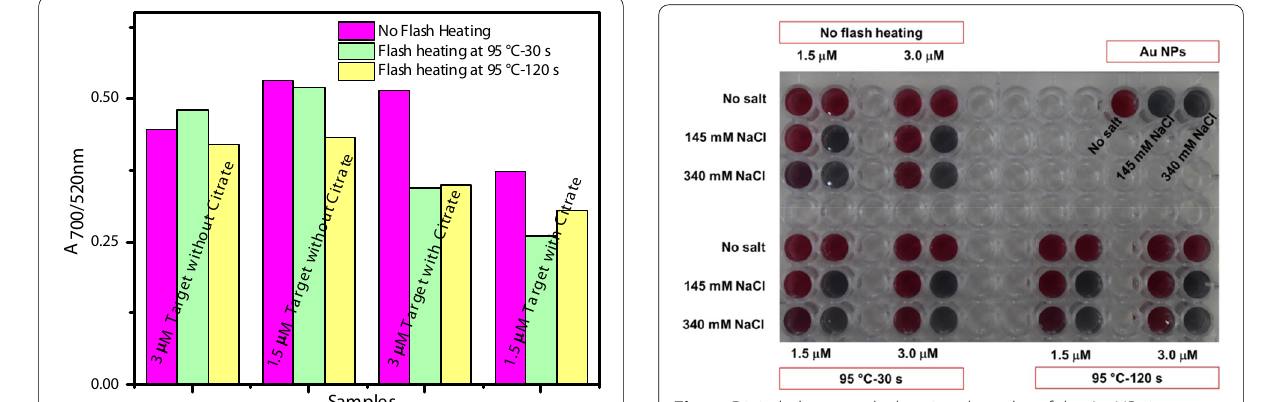
Fig. 4 Digital photograph showing the color of the Au NPs in citrate buffer—added with the target samples subjected to different hybridization conditions—before and after salting-out